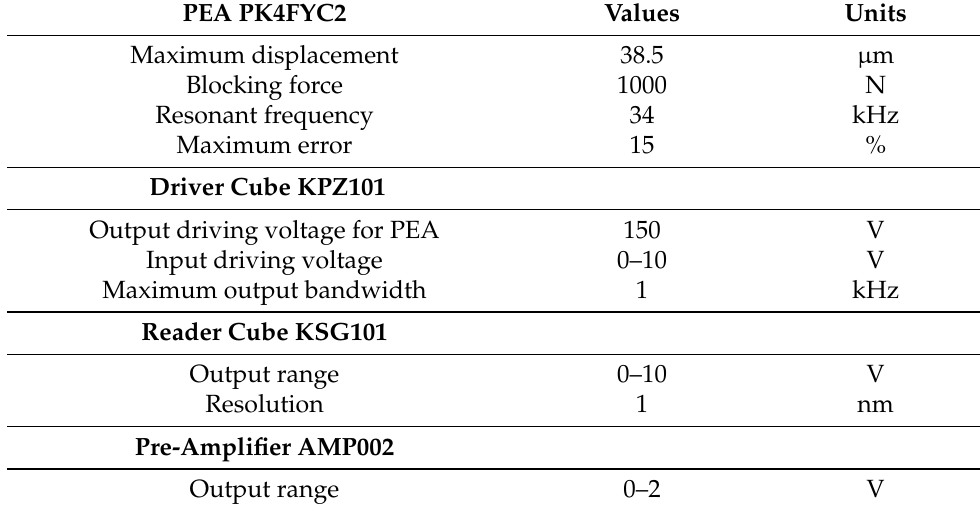
Table 1. Thorlabs hardware